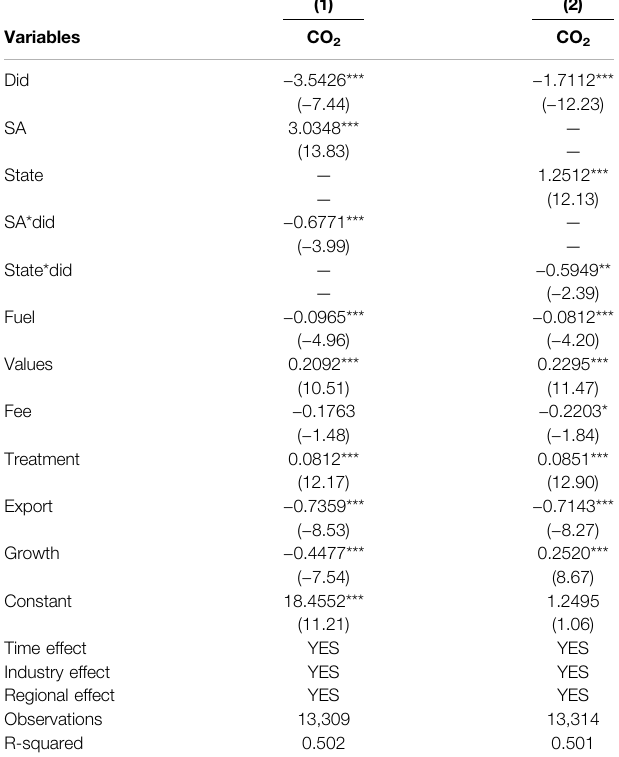
TABLE 6 | Moderation